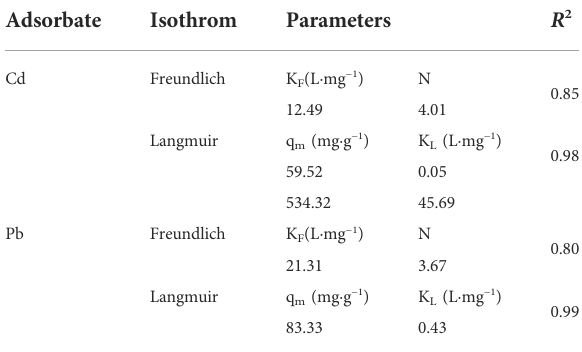
TABLE 2 Freundlich and Langmuir isotherms for Cd(II) and Pb(II)